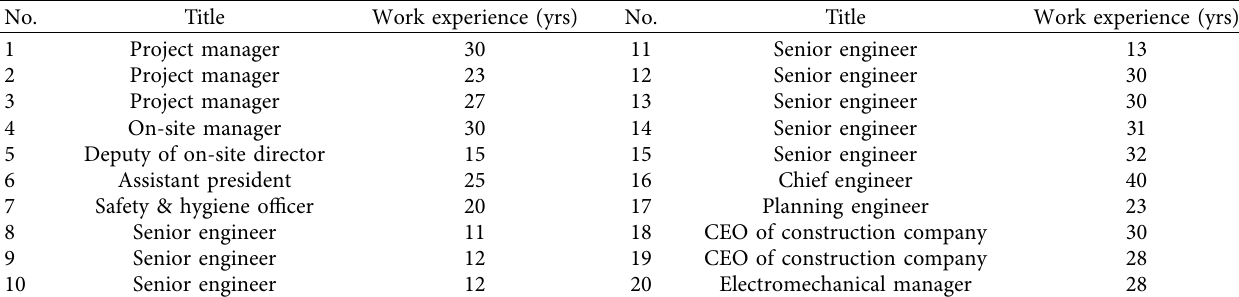
Table 4: Experts